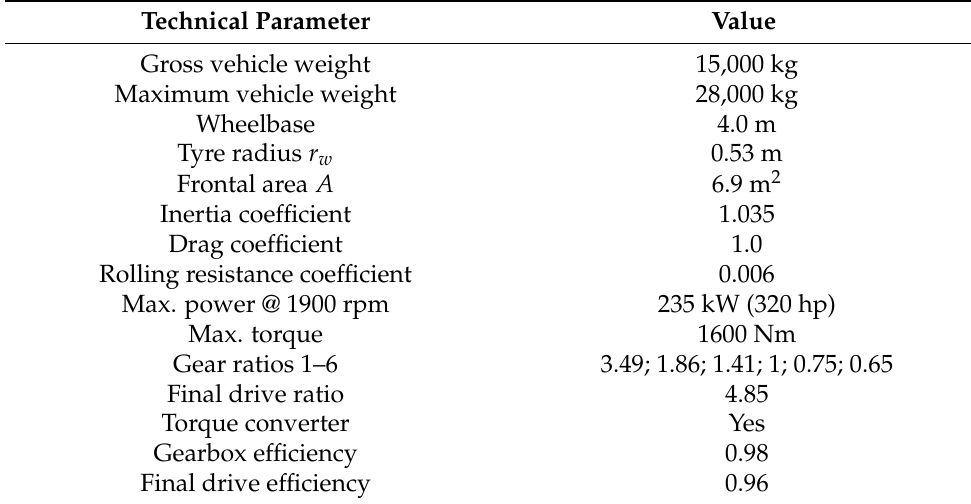
Table 1. Technical specification of the original diesel